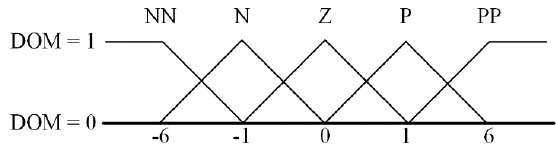
( d ) Figure 7. Various shapes of membership function. ( a ) Triangular; (b) Trapezoidal; ( c ) Polygonal; ( d ) Gaussian. The performance of the fuzzy logic control using the trapezoidal membership function is almost the same as that using the triangular membership function. However, the trapezoidal membership function is hard to implement when compared with the triangular membership function. In addition, the fuzzy logic control using the triangular membership function has no overshoot and fast dynamic characteristic when compared with that obtained when using the others [41]. Therefore, in this paper, the triangular membership function with an advantage of convenience of implementation was adopted among various shapes of the membership function [34,36]. The number and values of the triangular membership function should be set properly in order to achieve outstanding performance of the fuzzy logic control. The performance of the fuzzy logic control with a number of the membership functions can be improved, however, it has a computation burden. Therefore, in this paper, the number of the membership function was set to five. Additionally, the values of the membership function are determined by experiences and intuitions because the fuzzy logic control is readily customized in human language terms. The output voltage